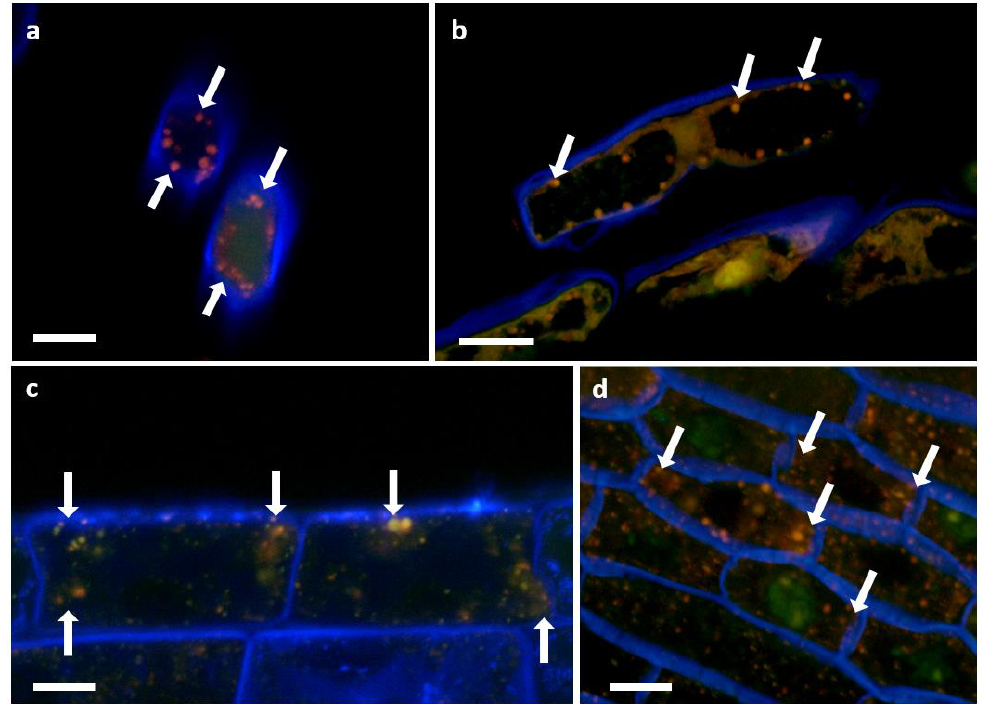
Figure 12. P3AW: mCherry localizes to the cell periphery near the cell wall. ( a ) Front view and ( b ) side view of sloughed-off root cells of P3AW: mCherry -inoculated clover. Side view of ( c ) epidermal cells and ( d ) sclerenchyma cells of P3AW: mCherry -inoculated clover. The arrows point to the spher- ical L-forms of P3AW: mCherry , which can be found near the cell periphery, close to the cell wall. Scale bar = 10 μm.